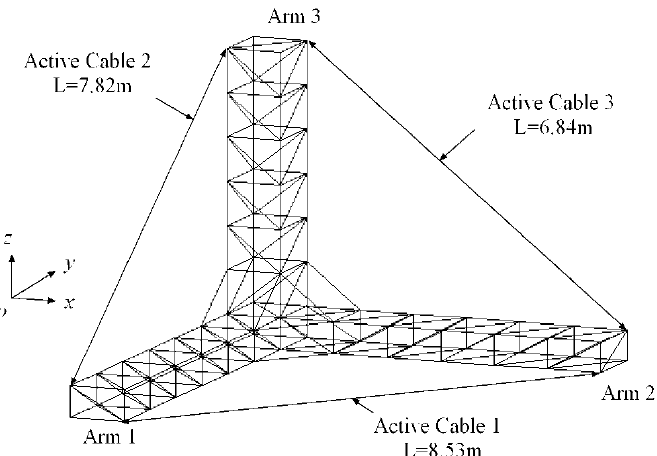
Figure 1. Guyed truss